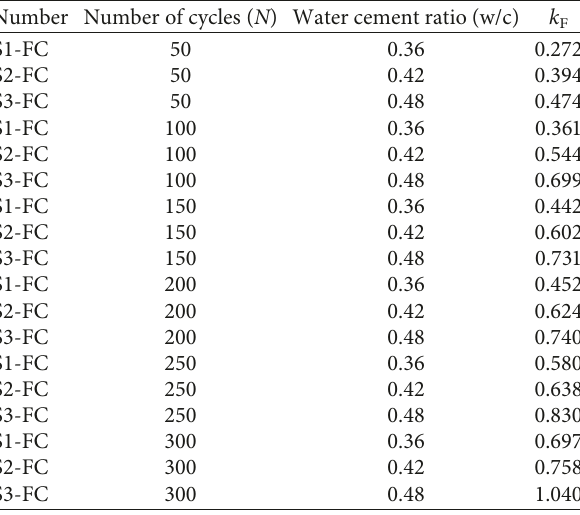
Table 8: Calculated values of k